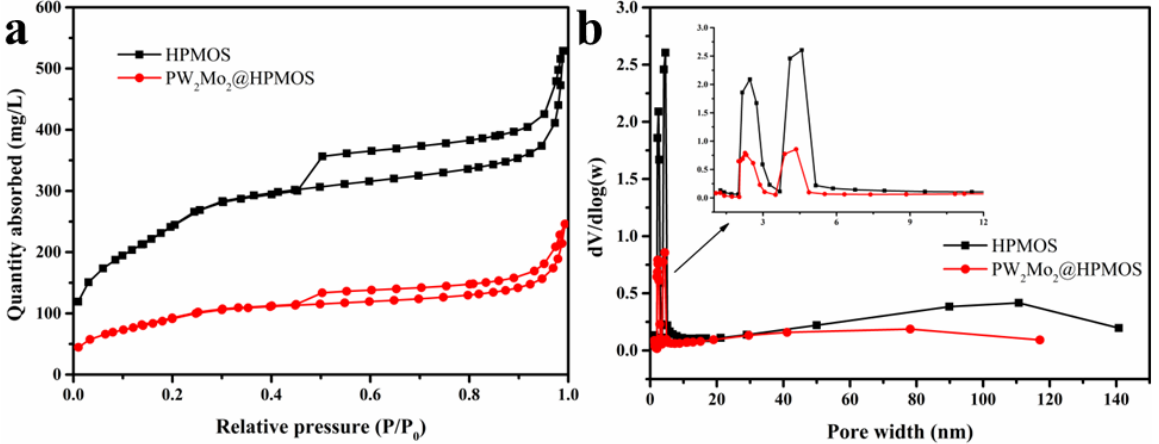
Figure 3. TG curves of PW 2 Mo 2 , HPMOS, and PW 2 Mo 2 @HPMOS.